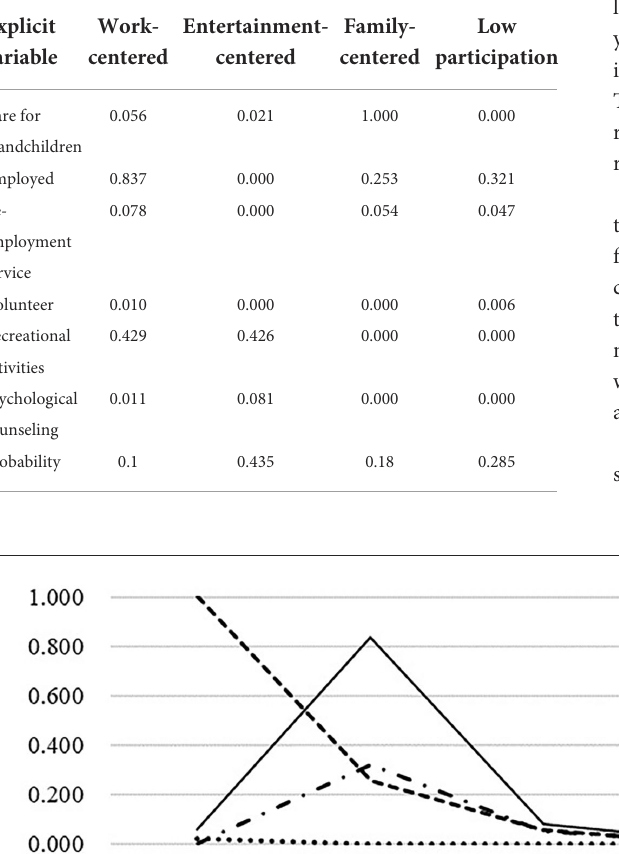
TABLE 5 The latent class coefficients of three-class social participation profile ( N = 913).